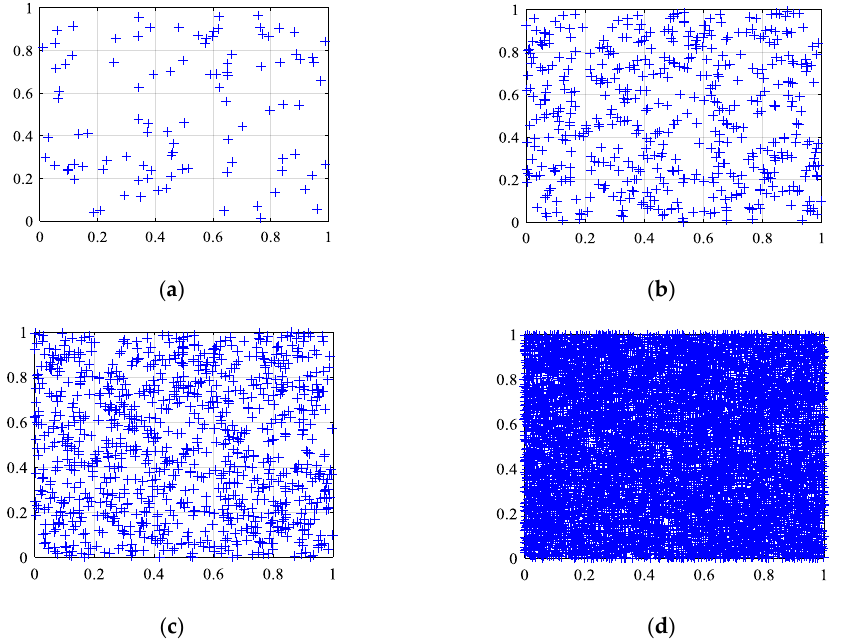
Figure 1. Illustrations of an example to generate random samples used in the MC technique with different numbers of samples, which include: ( a ) 100 samples, ( b ) 500 samples, ( c ) 1000 samples, and ( d ) 10,000 samples, respectively.